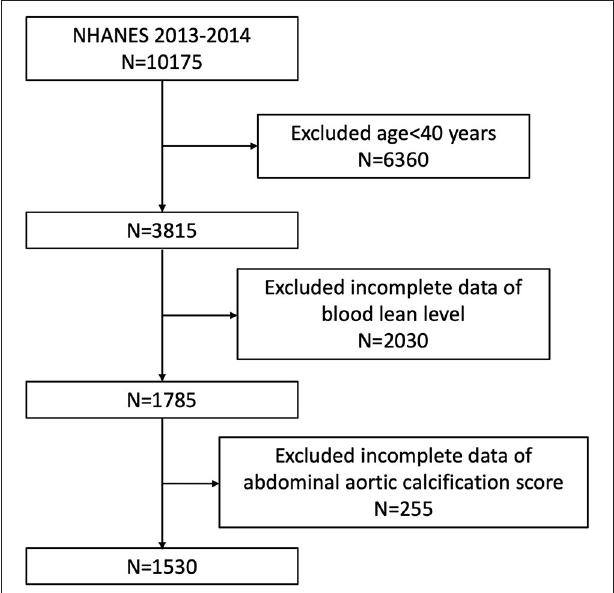
FIGURE 1 | Flowchart of the sample selection from NHANES